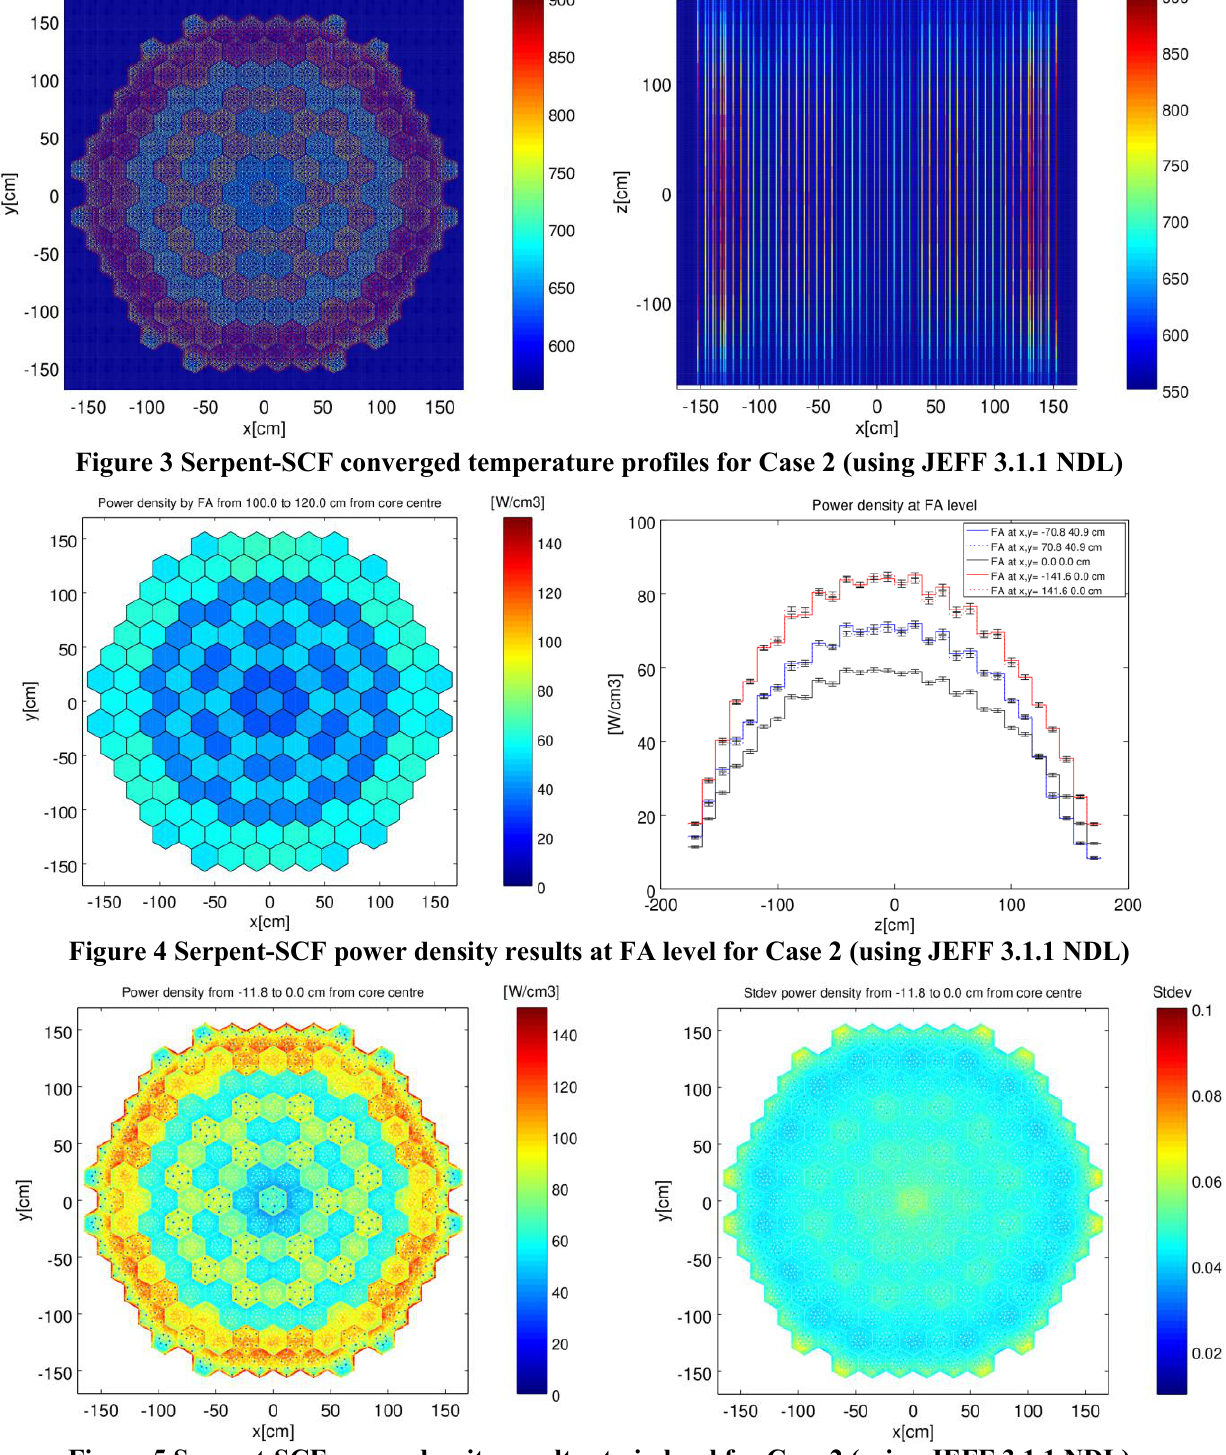
Figure 5 Serpent-SCF power density results at pin level for Case 2 (using JEFF 3.1.1